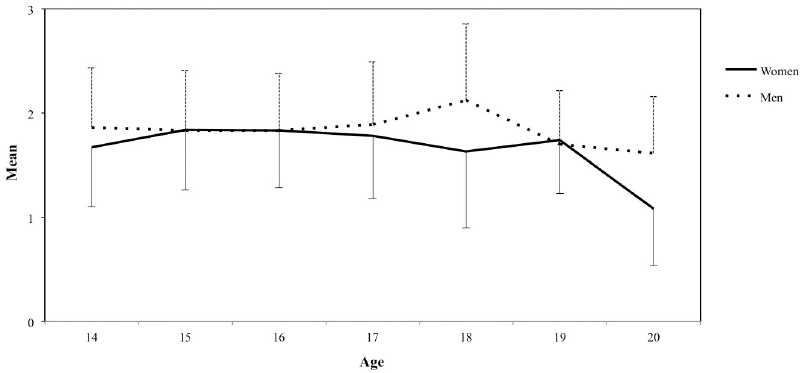
Fig 4. Interaction between gender and age variables for Sophisticated